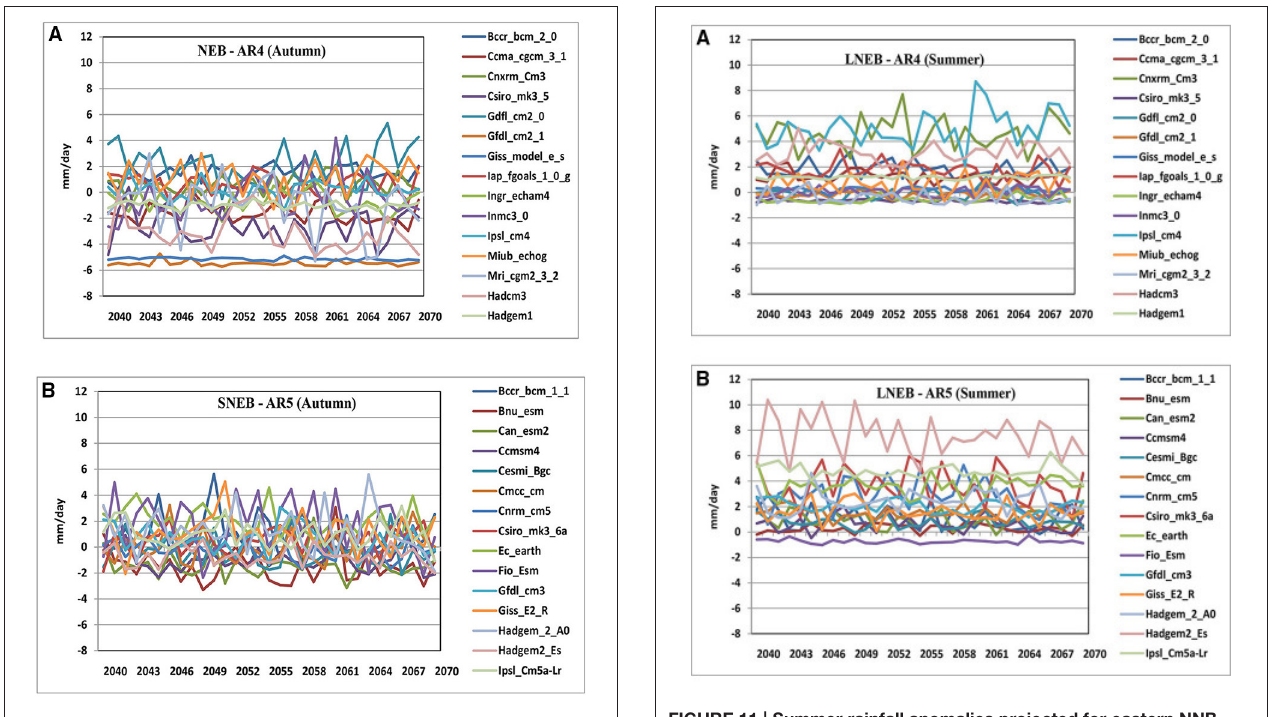
FIGURE 10 | As Figure 9 except for autumn.